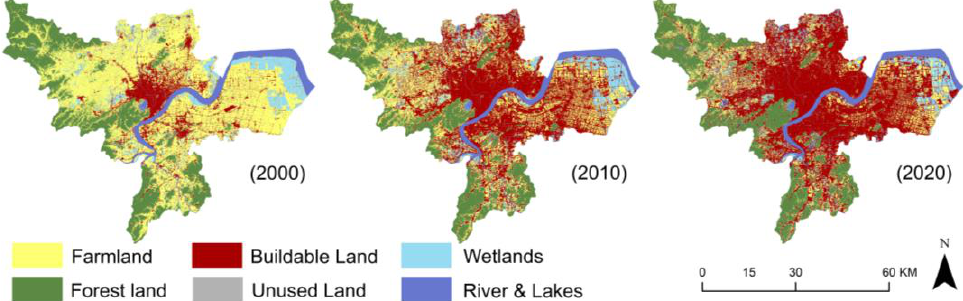
Figure 2. Land use of the study area in 2000, 2010, and 2020.